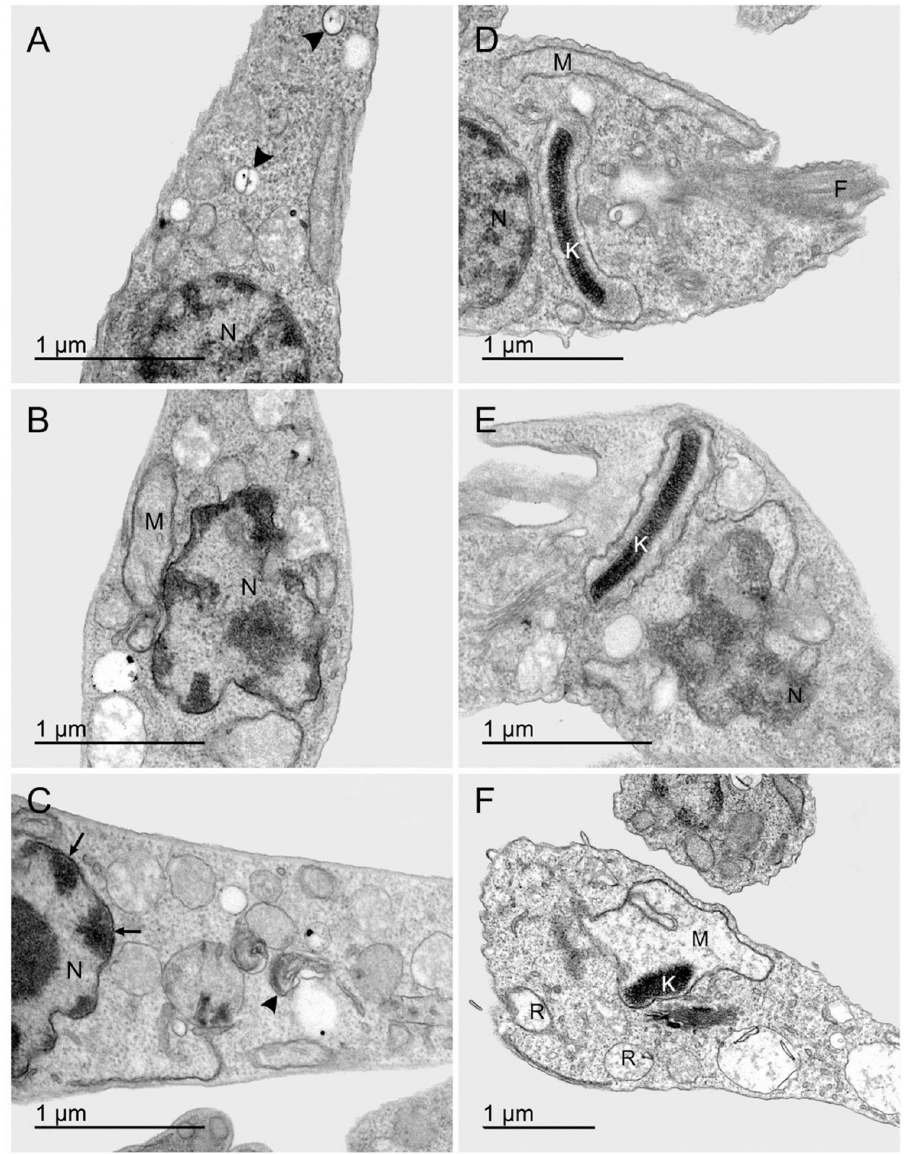
Fig 6. Effects of nimesulide on T . cruzi . A : Calciosomal acids distributed in the cytoplasm, indicated by arrowheads and intact nucleus (N), in the untreated control. After treatment with nimesulide, B : Nucleus (N) with disruption of the nuclear envelope, dilated mitochondria (M) and presence of vacuoles, and C : Disorganized nucleus (N) with heterochromatin adhered to some sections of the nuclear envelope (straight arrows), figures of myelin are present in the cytosol, represented by the arrowhead. D : Well-preserved mitochondrial profile, close to the plasma membrane, the kinetoplast (K) also shows the kDNA preserved in the mitochondrial portion between the nucleus (N) and the flagellum (F), in the untreated control. After treatment with nimesulide, E : The treatment induced profound alterations on nuclear morphology (N) and kinetoplast condensation (K), and F : Mitochondria (M) well dilated and with loss of ridges throughout the parasite body, electrodense kinetoplast (K) and presence of the reservosomes (R) with low content.